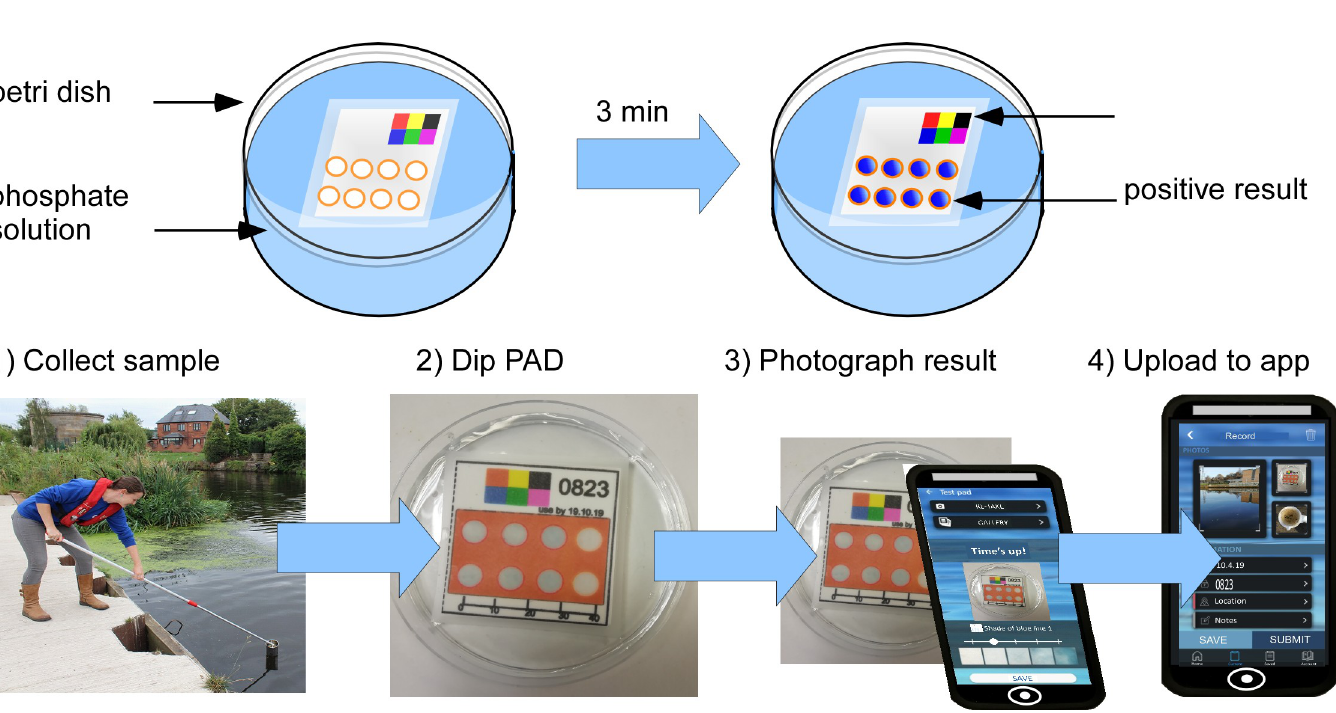
PLOS ONE | https://doi.org/10.1371/journal.pone.0260102 December9, 2021 4 /